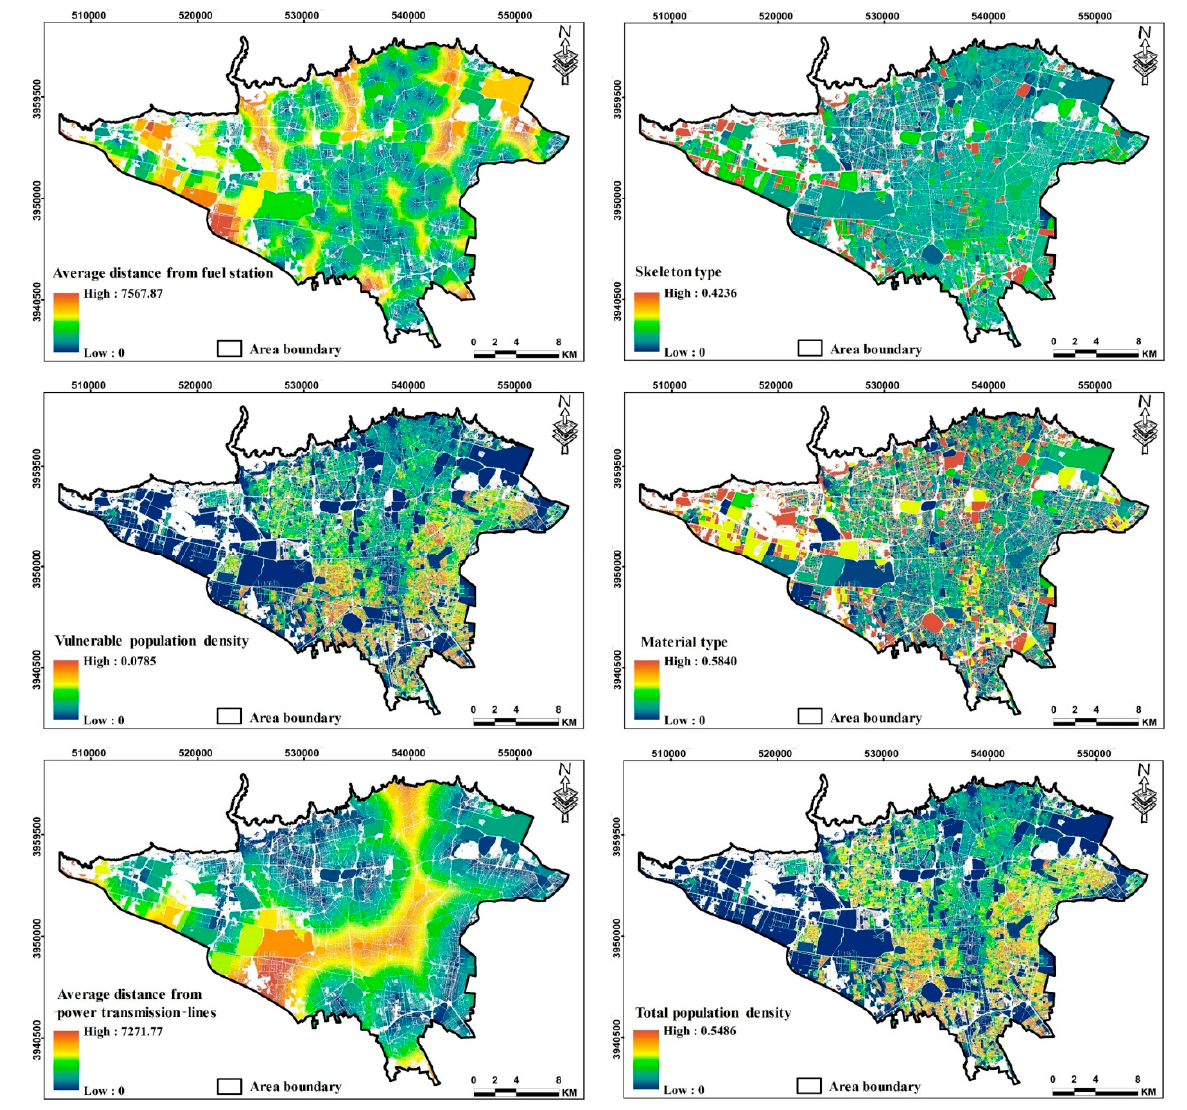
Figure 6. Map of sensitivity criteria.